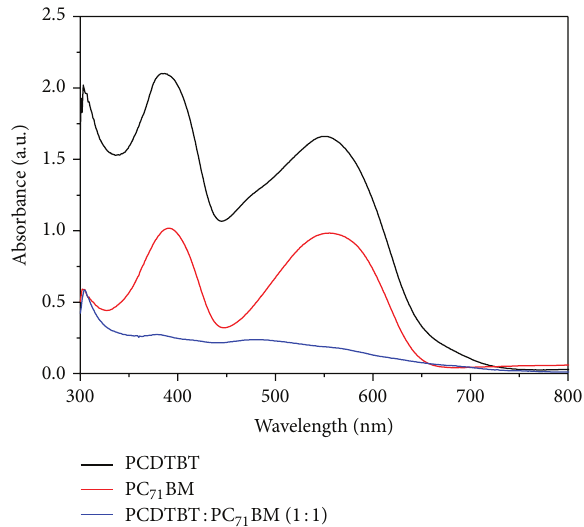
Figure 7: UV-vis absorption spectra of pristine PCDTBT and PC 71 BM and PCDTBT: PC 71 BM layer in